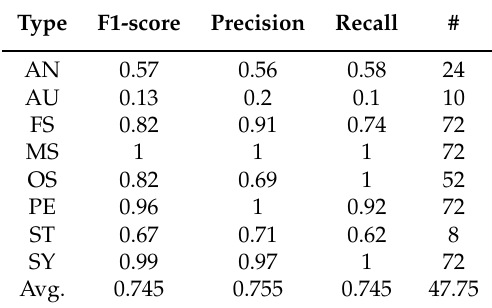
Table 8. Manual model 1 (the augmented